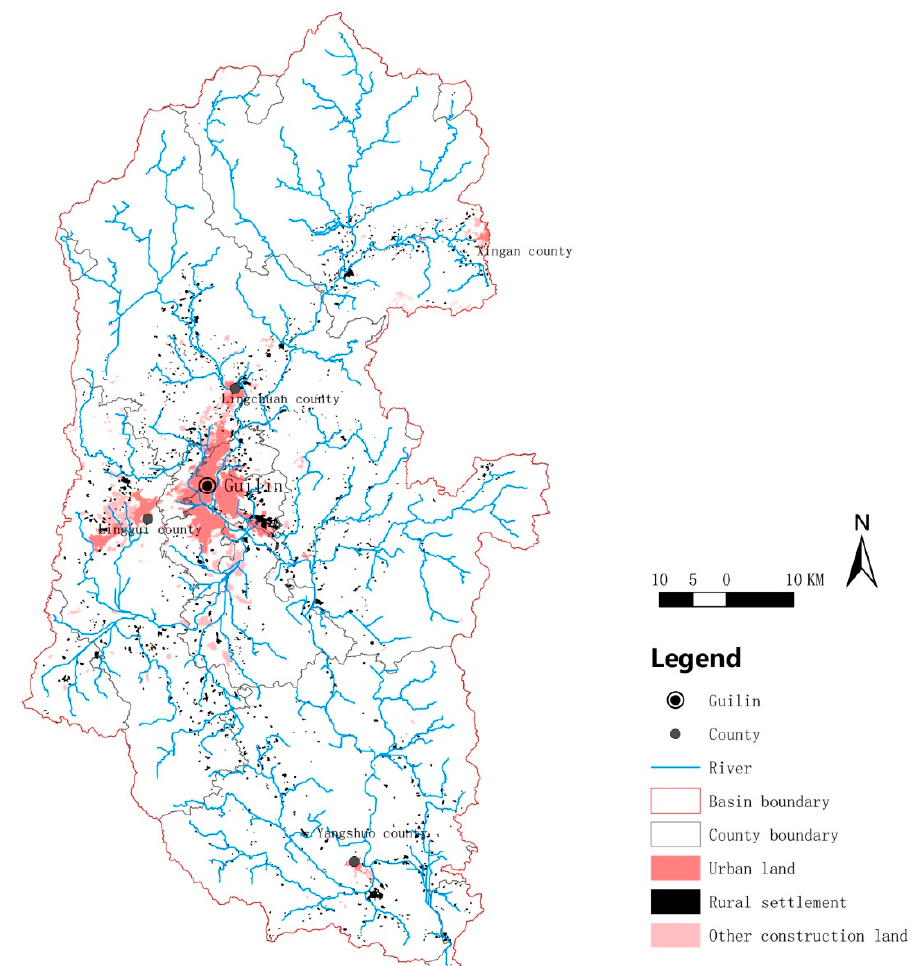
Figure 9. Distribution of urban land and rural settlements in the Lijiang River Basin.